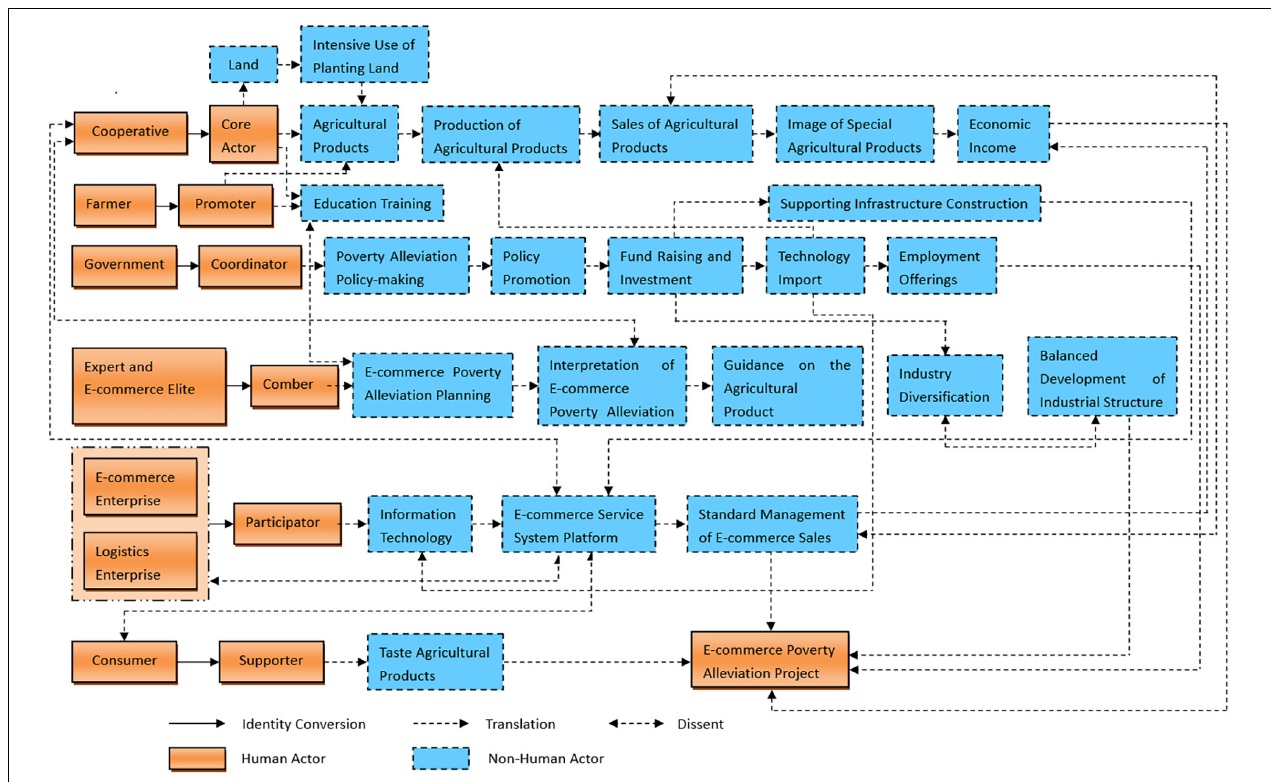
FIGURE 5 | The construction of EPAAN